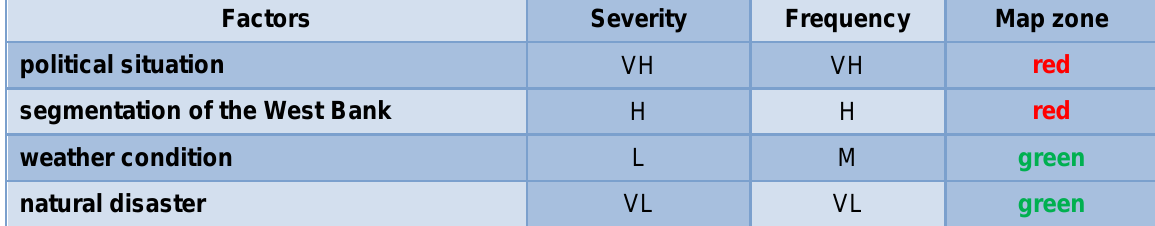
Table 6 Risk map for factors under external group Construction items Group